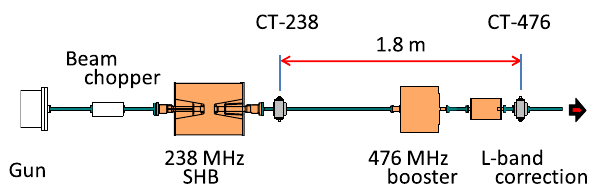
FIG. 16. Layout of the injector beginning part in SACLA including the beam chopper, the 238 MHz SHB cavity, the 476 MHz booster cavity, the L-band correction cavity and the DCTs of just after both cavities.